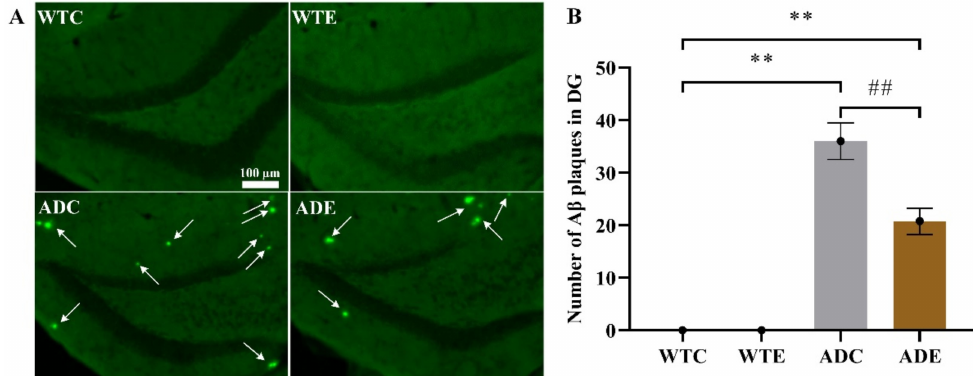
Figure 2. Effect of treadmill exercise on A β deposition in mice. ( A ) A β thioflavin-S staining in the hippocampus. ( B ) A β plaque quantification in the hippocampus. n = 4 for each group. ** p < 0.01 compared with WTC. ## p < 0.01 compared with ADC. The arrows point to the A β plaques.